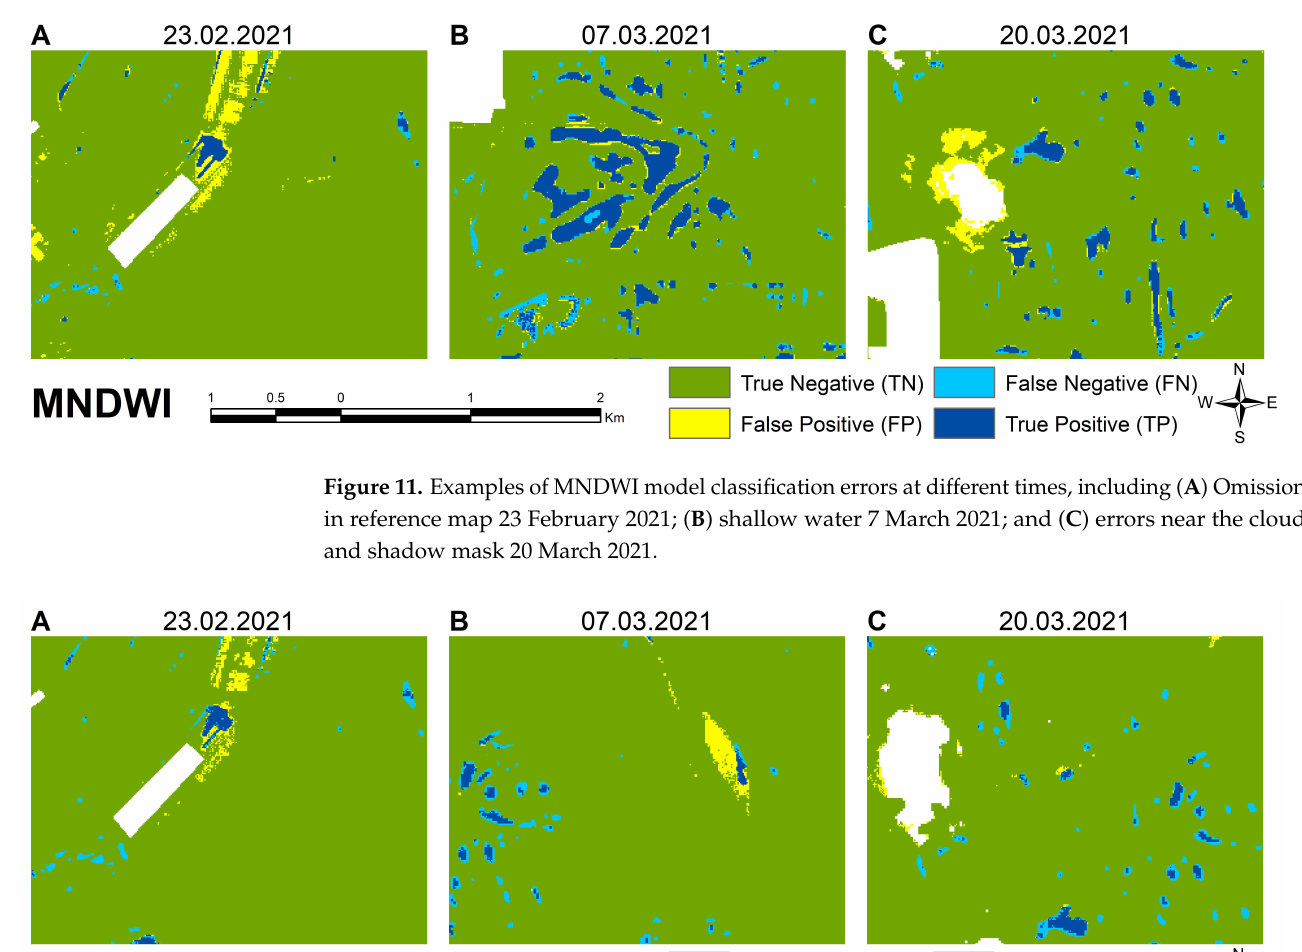
Figure 10. Examples of NDWI model classification errors at different times. ( A ): scattered buildings and roads 23 February 2021; ( B ): bare soils adjacent to roads 7 March 2021; and ( C ): strong errors near the cloud and shadow mask 20 March 2021.